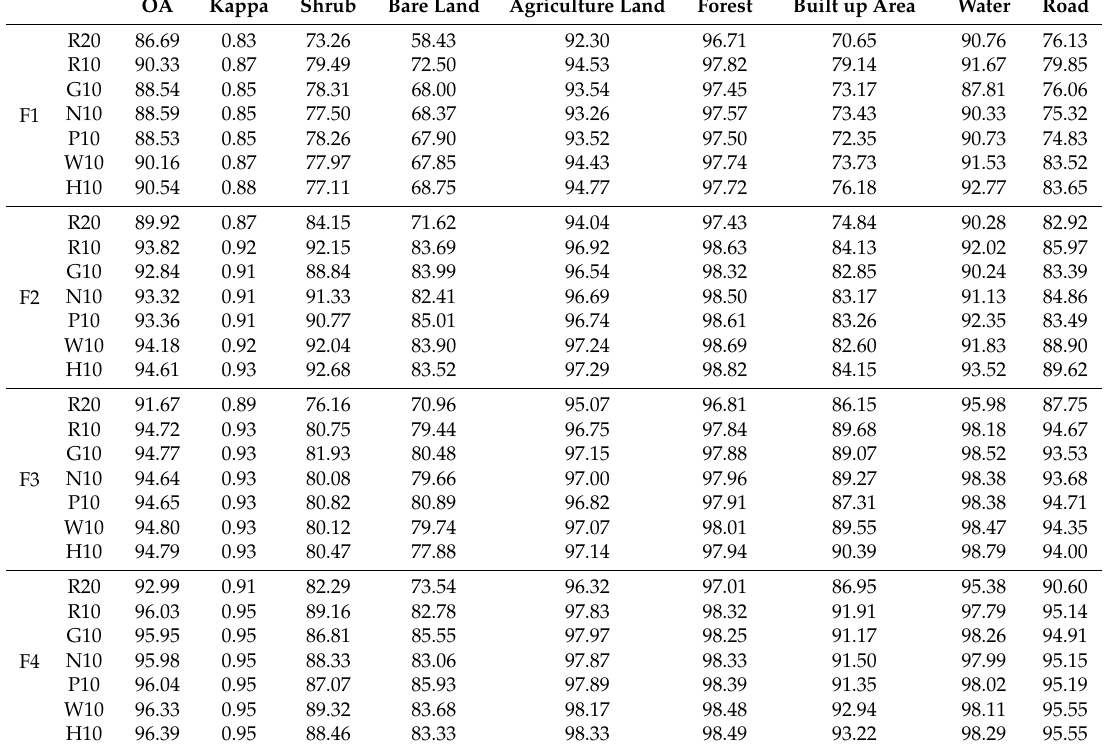
Table 5. Classification accuracies (in percentage, OA: overall accuracy, Kappa: kappa